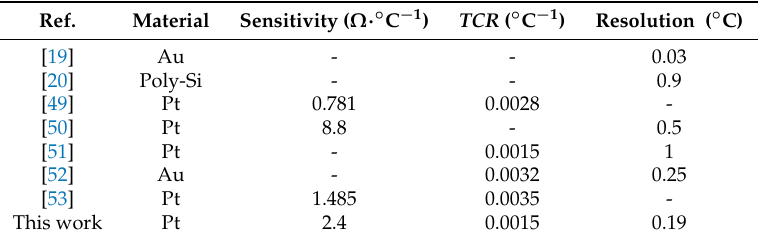
Table 3. Comparison of RTD developed in this work and previous studies.